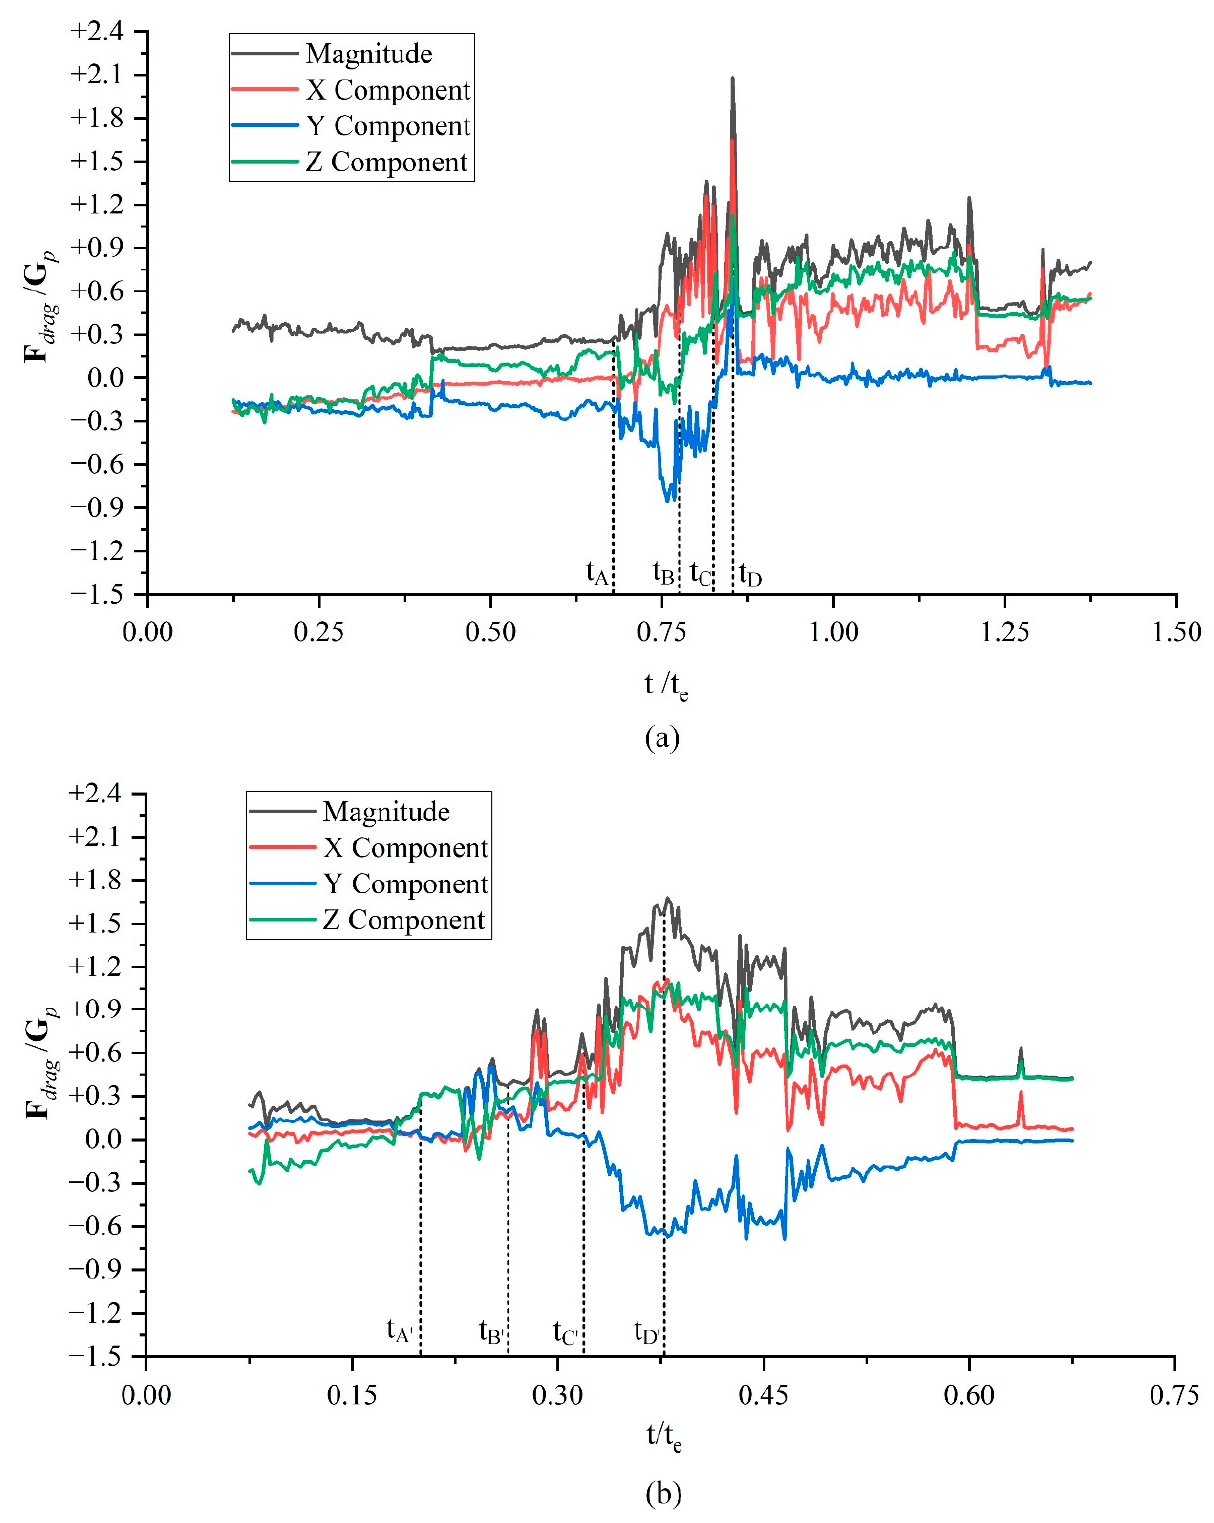
Figure 18. Drag time history of particles: ( a ) particle 1 and ( b ) particle 2.